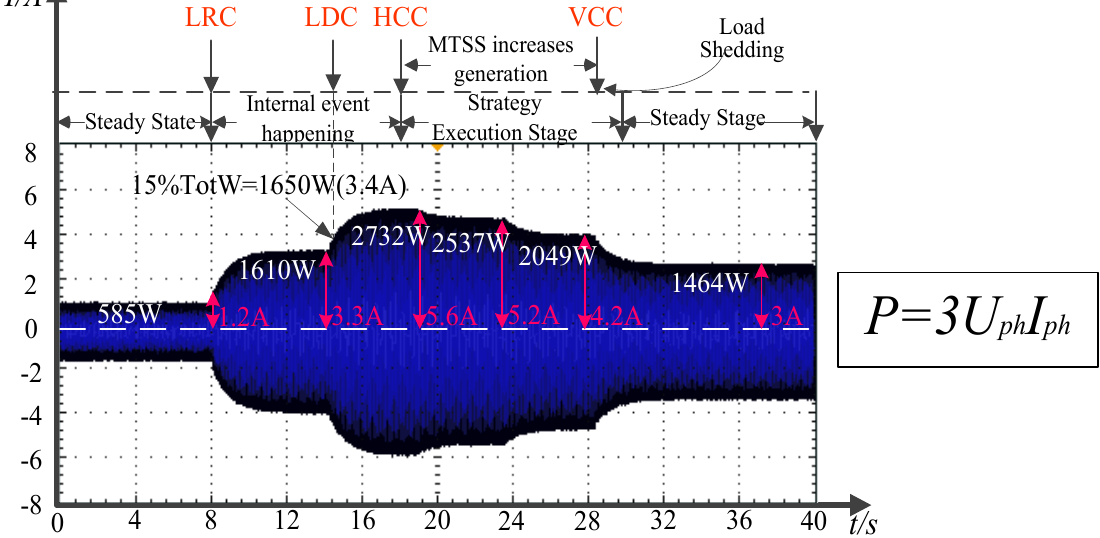
Figure 13. Changes of the active power absorbed from the connected grid in Scenario